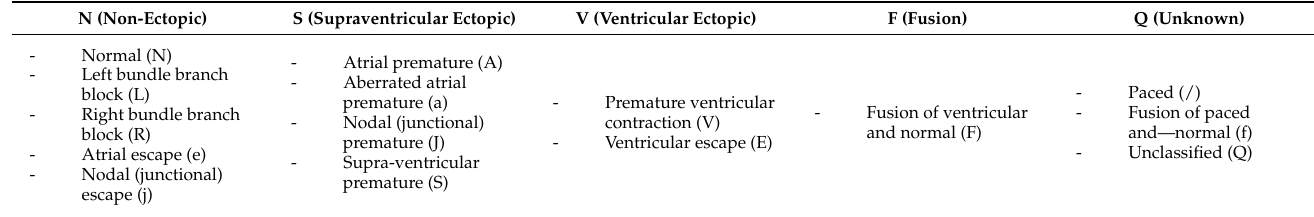
Table 1. Five kinds of heartbeat annotated in